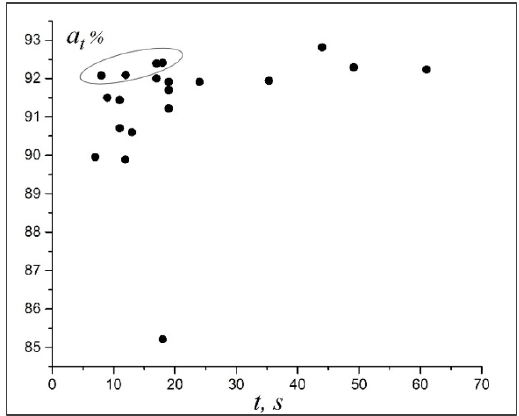
and the number of parameters P of the neural a t